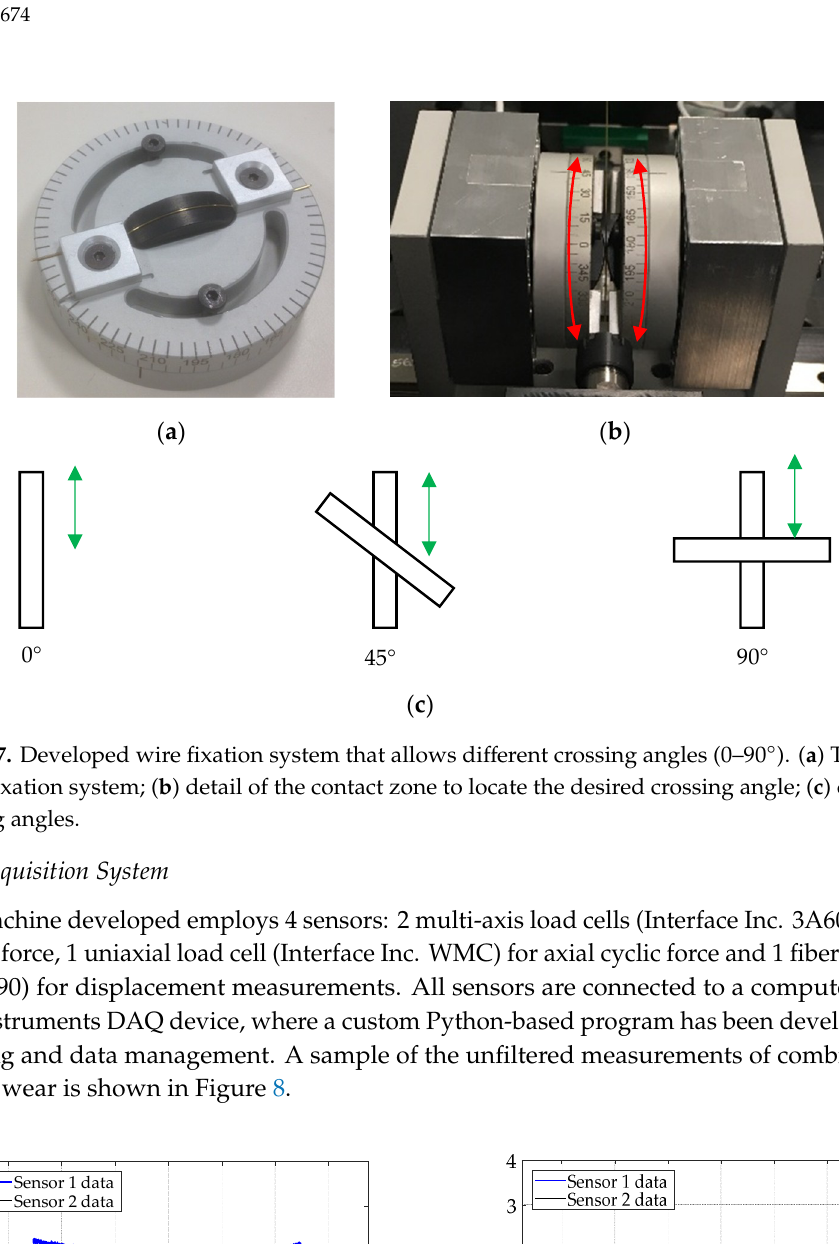
Figure 9. Image of 3D measurement of wear scar and 2D profile extraction procedure. 3. Description of Experimental Tests In this work, fretting fatigue tests were carried out on 0.45 mm diameter cold-drawn eutectoid carbon steel (0.8% C), which are summarized in Table 1. Each test configuration was repeated 3 times to ensure repeatability. The objective of these tests was to analyse the effect of the crossing angle on the measured tribological quantities such as the frictional force that can serve as a baseline for future works. Table 1. Fretting fatigue (FF) test summary. Test Number